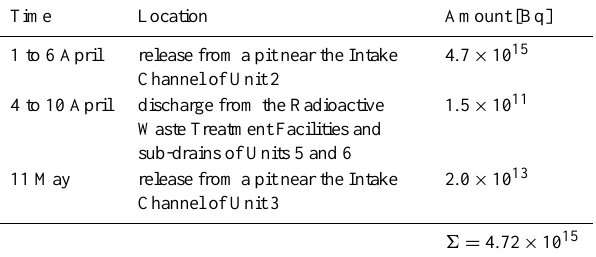
Table 1. Estimate of radioactive materials discharged to the sea at Fukushima Dai-ichi nuclear power station according to Japanese Government